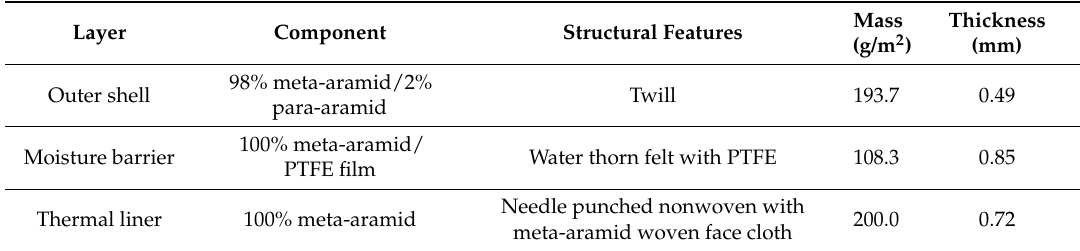
Table 1. Basic properties of the testing